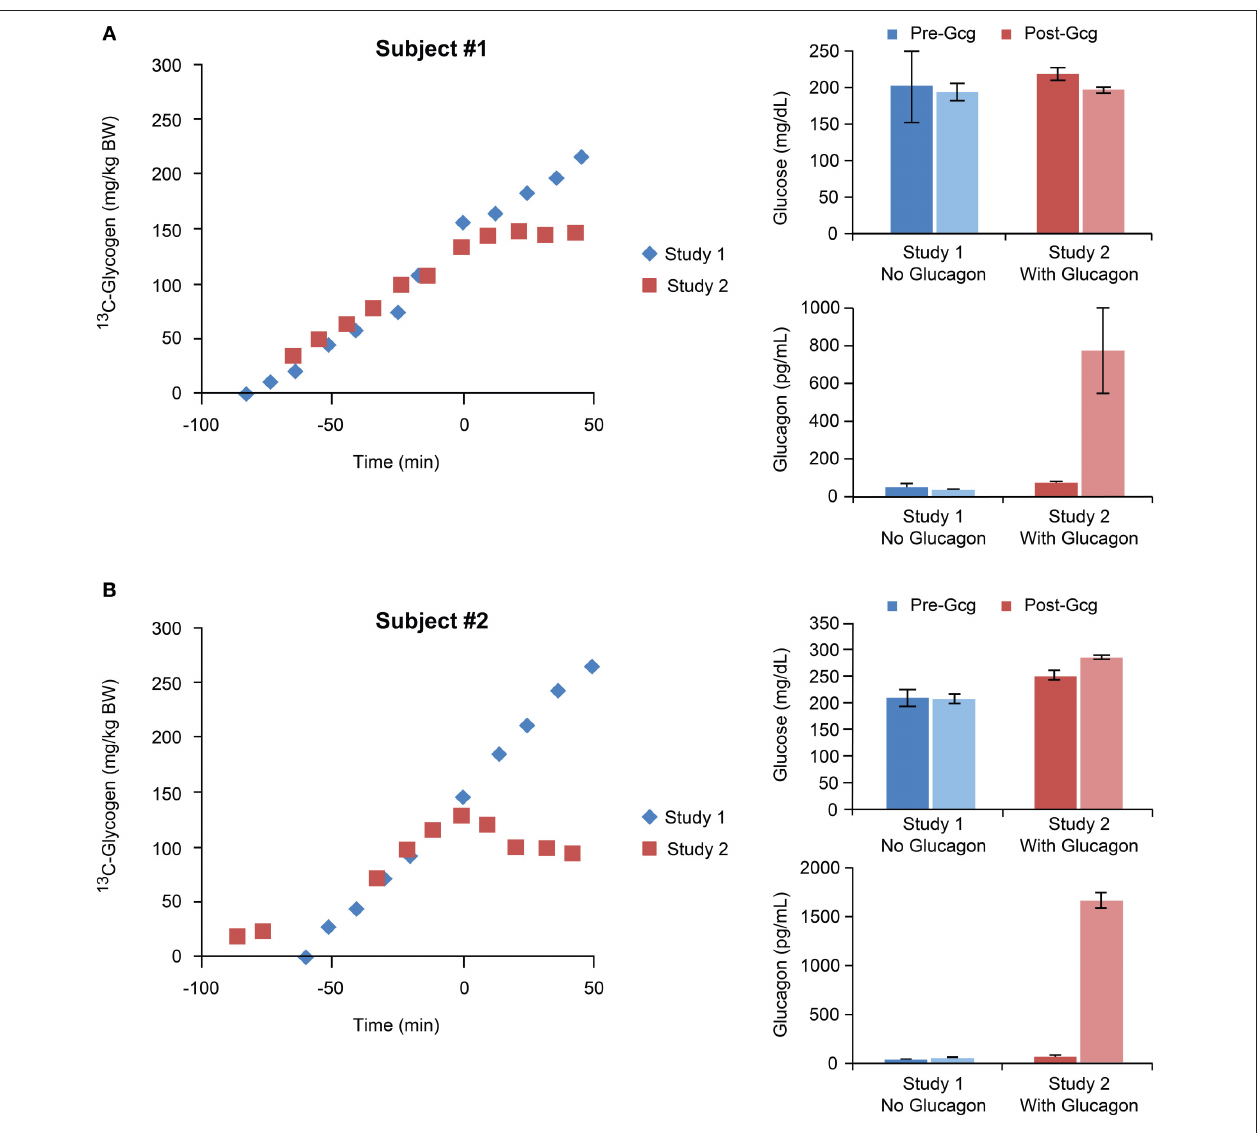
FIGURE 7 | Time courses of 13 C-glycogen and corresponding average values of circulating glucose and glucagon for individual studies performed with and without glucagon infusions for subject #1 (A) and subject #2 (B) . In both subjects, the glucagon infusion resulted in marked increases in circulating glucagon levels, and accordingly, suppression of hepatic glycogen